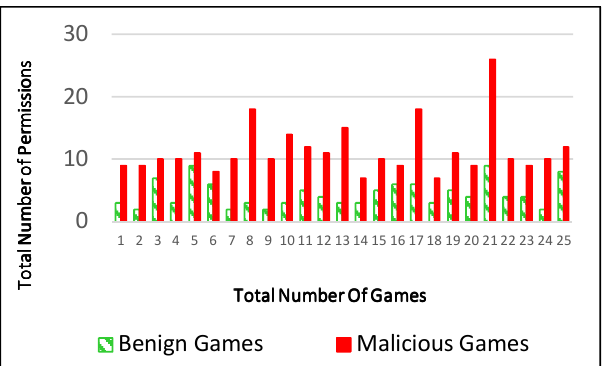
Fig. 9: Comparison of Requested Permissions